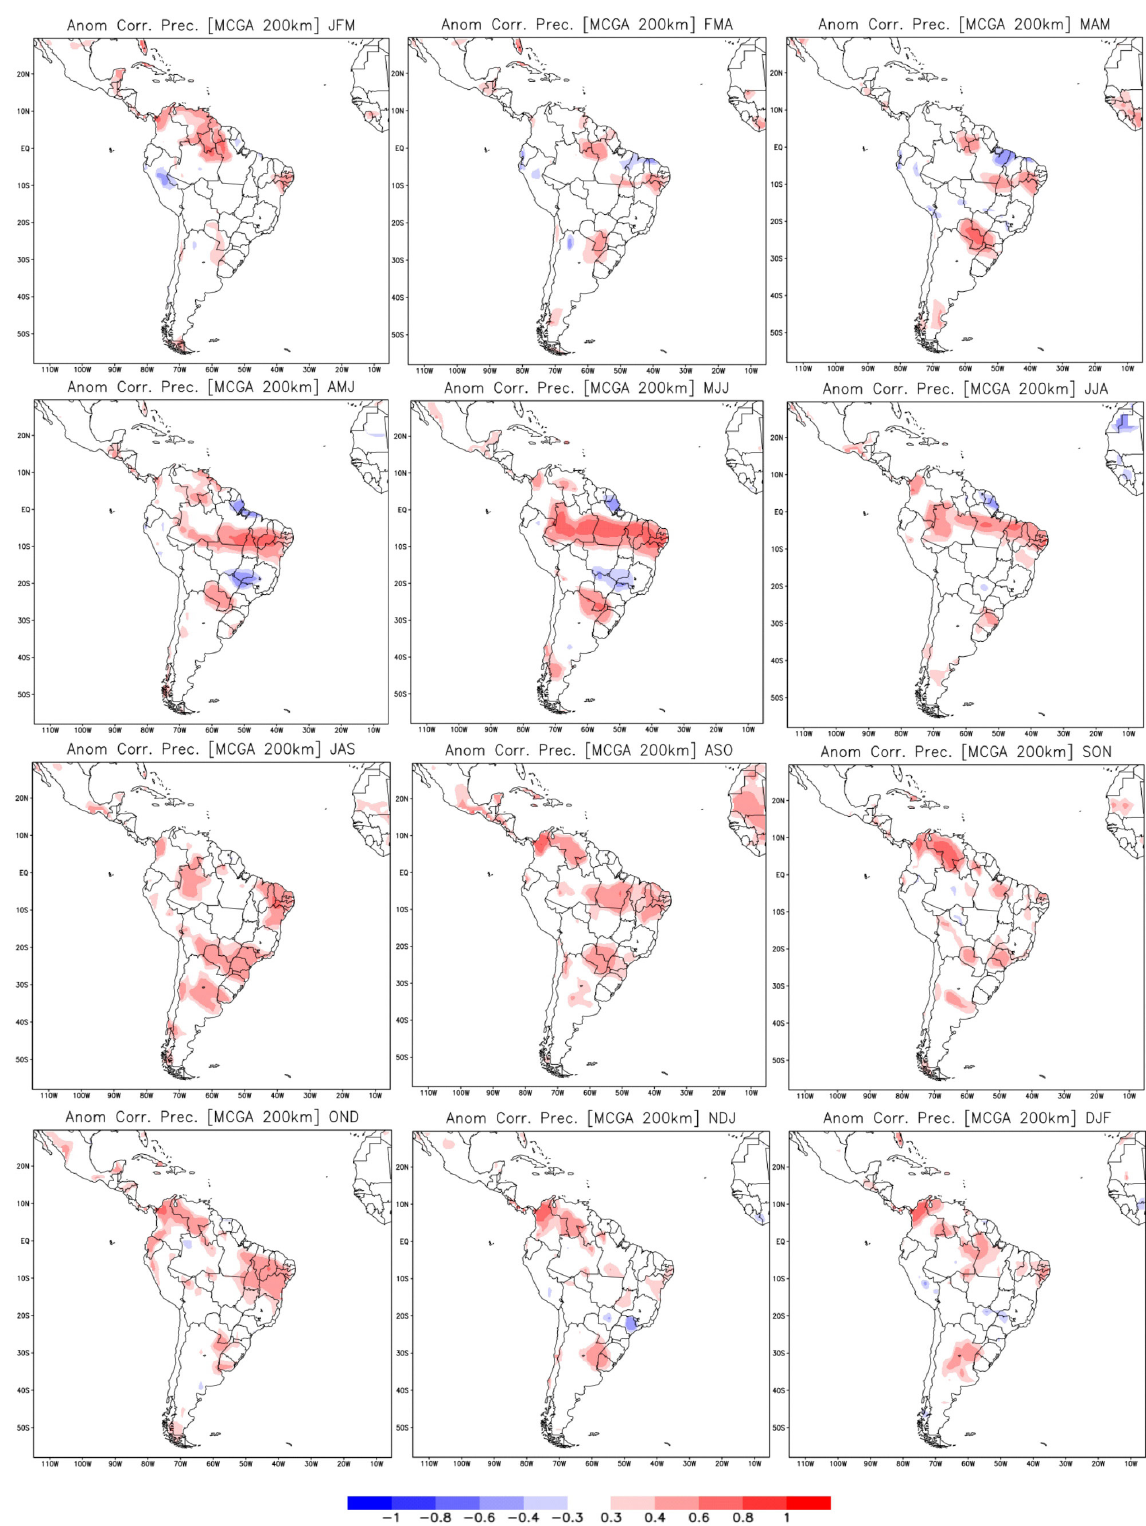
Figure 11. Precipitation skill scores for the CPTEC global atmospheric climate model with two-month lead time for the seasons: JFM, FMA, MAM, AMJ, MJJ, JJA, JAS, ASO, SON, OND, NDJ, and DJF. The score is